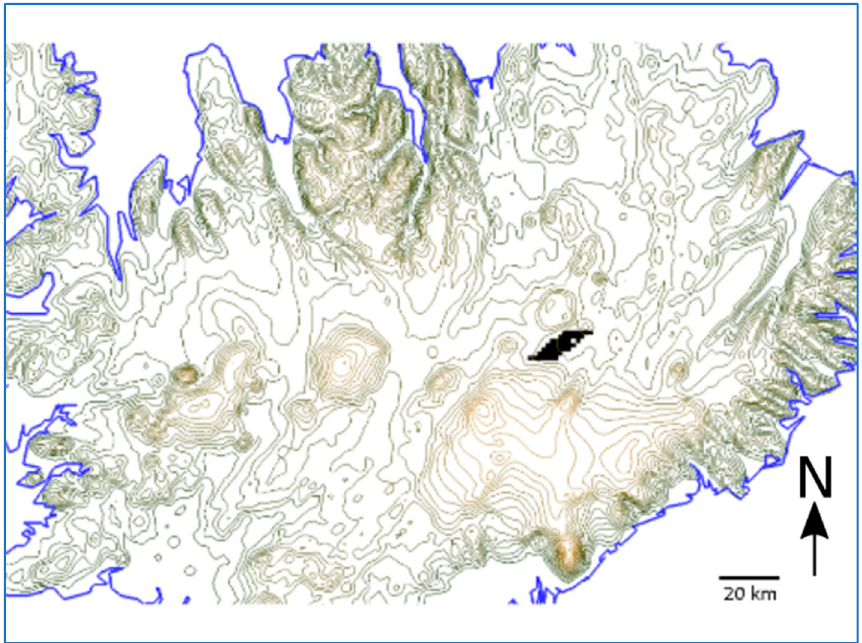
Figure 12. Topography of Iceland (coastline in solid blue line) with elevation contour intervals every 100 m; the solid black shaded area represents the Holuhraun fissure.